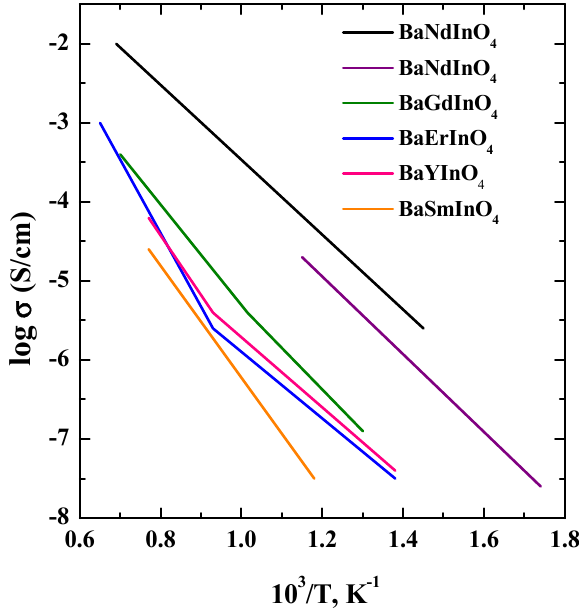
Figure 8. The temperature dependencies of electrical conductivities of compositions BaNdInO 4 (violet) [72], BaNdInO 4 (black) [73], BaGdInO 4 (green) [73], BaErInO 4 (blue) [73], BaYInO 4 (pink) [73], BaSmInO 4 (orange) [73].